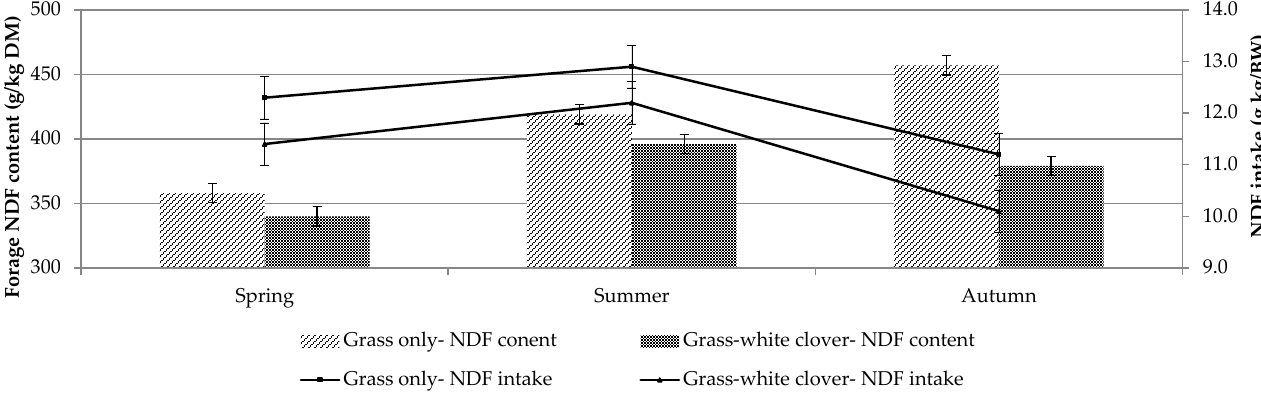
Figure 3. Forage in vivo OMD and forage neutral detergent fibre (NDF) concentration of grass-only and grass-white clover swards offered to individually housed sheep in spring (27 March – 29 April), summer (19 June – 22 July) and autumn (4 – 29 September) (measured > 4 cm).